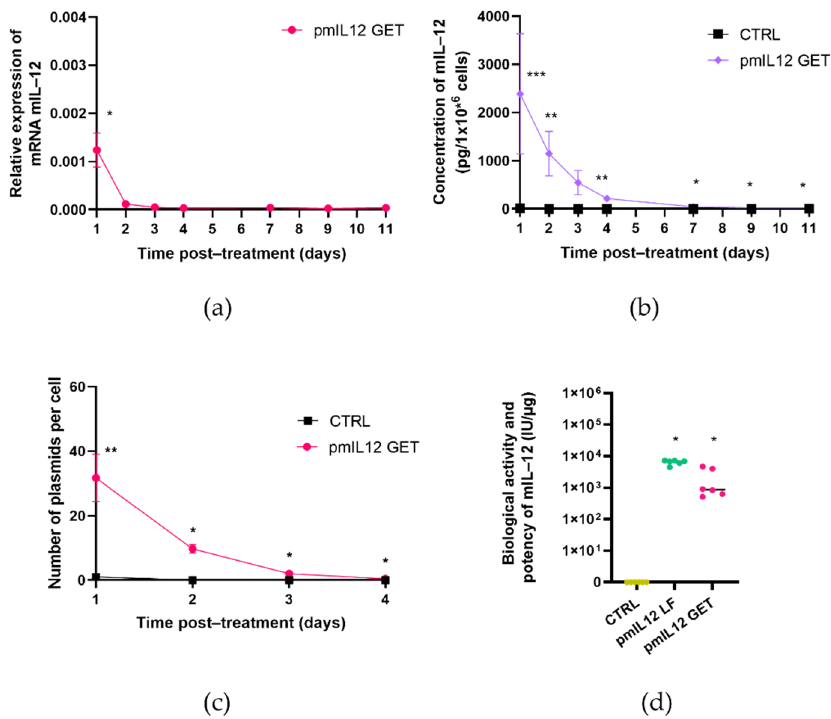
Figure 6. GET of pmIL12 in the CT26 cell line. ( a ) Relative expression of mIL-12 mRNA in the target cells; * p < 0.0001—statistically significant difference compared to all the other timepoints. ( b ) Expression of mIL-12 on the protein level; * p < 0.05—statistically significant difference compared to the protein concentration at day 1 and the control; ** p < 0.05—statistically significant difference compared to the control; *** p < 0.05—statistically significant difference compared to the protein concentration at days 7, 9 and 11. ( c ) Copy number of plasmid DNA per cell; ** p < 0.005—statistically significant difference compared to the copy number at days 2, 3 and 4 and the control; * p < 0.005—statistically significant difference compared to the copy number at day 1 and the control. ( d ) Biological activity and potency of the mIL-12 protein in control untreated cells (dark yellow), in pmIL12 Lipofectamine (LF) transfected cells (green) and in pmIL12 gene electrotransfer (GET) transfected cells (pink); * p < 0.05—statistically significant difference compared to the control cells. All the experiments were repeated three times, each of them including two separate biological replications.